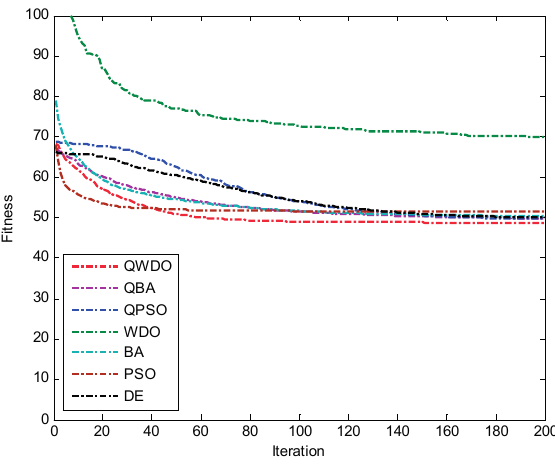
Figure 20. Fitness of the second instance for Maxgen = 150.